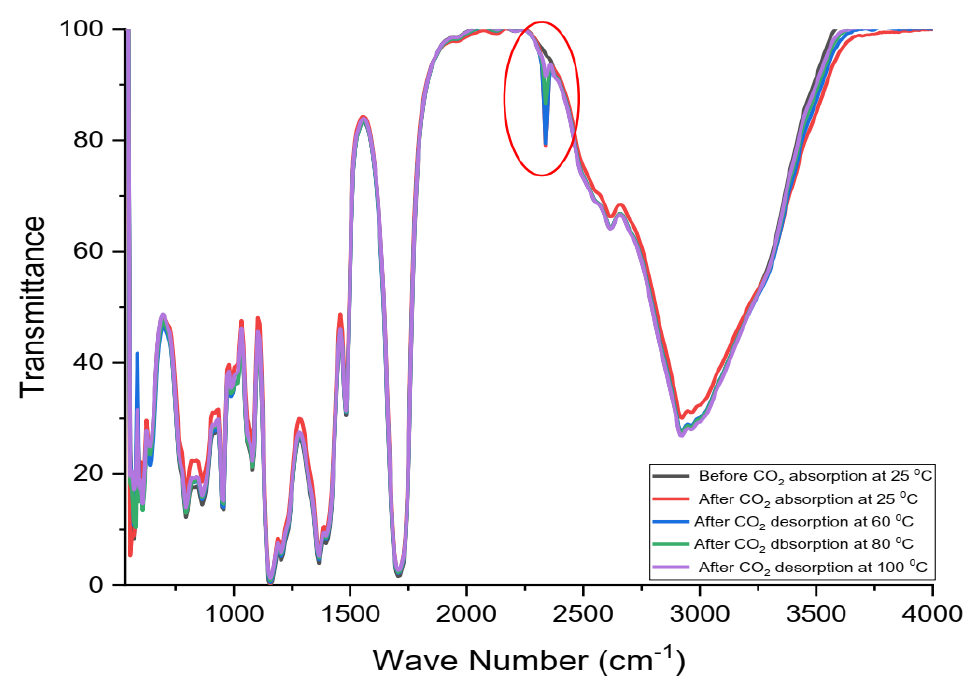
Figure 10. The FTIR spectra of ChCl:LvAc (1:3:0) before and after CO 2 absorption at 25 °C and CO 2 desorption at different temperatures.